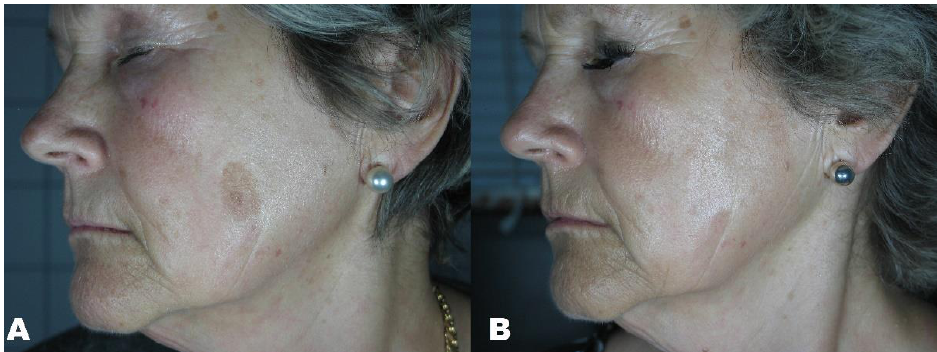
Figure 6. ( A ) Hypermelanosis before treatment; ( B ) region three months after the last session.